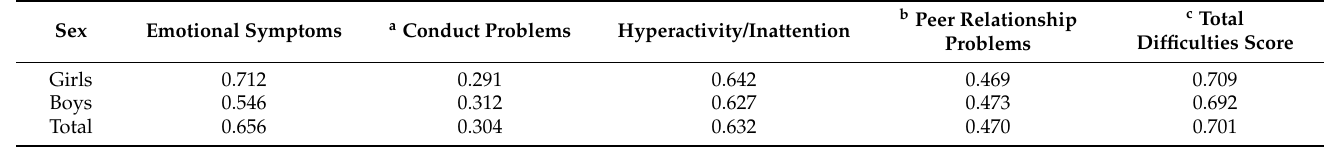
Table A4. Internal consistencies (Cronbach’s alpha) of SDQ subscales in the 2018 sample.